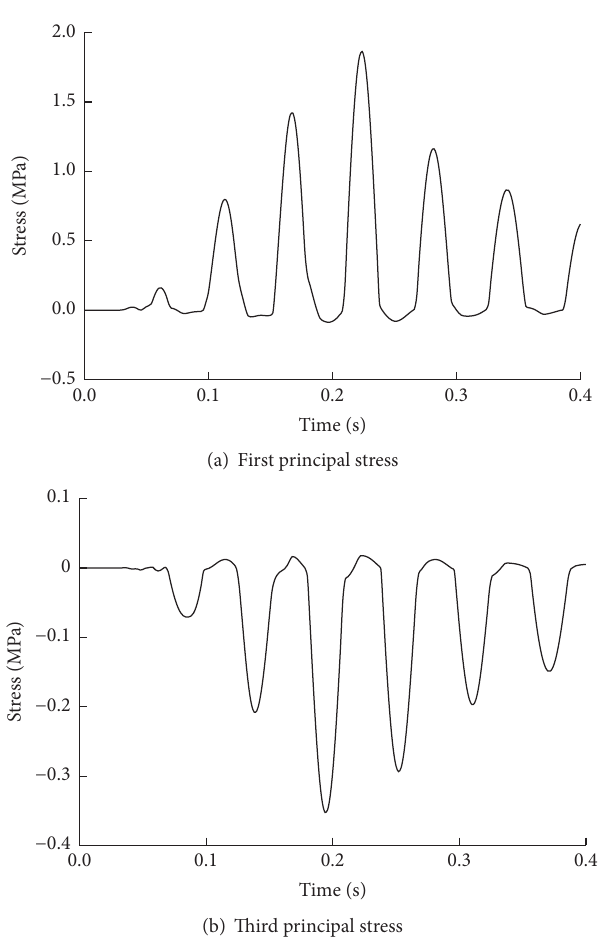
Figure 15: Time-history curve of principal stress at the element where maximum damage occurs.